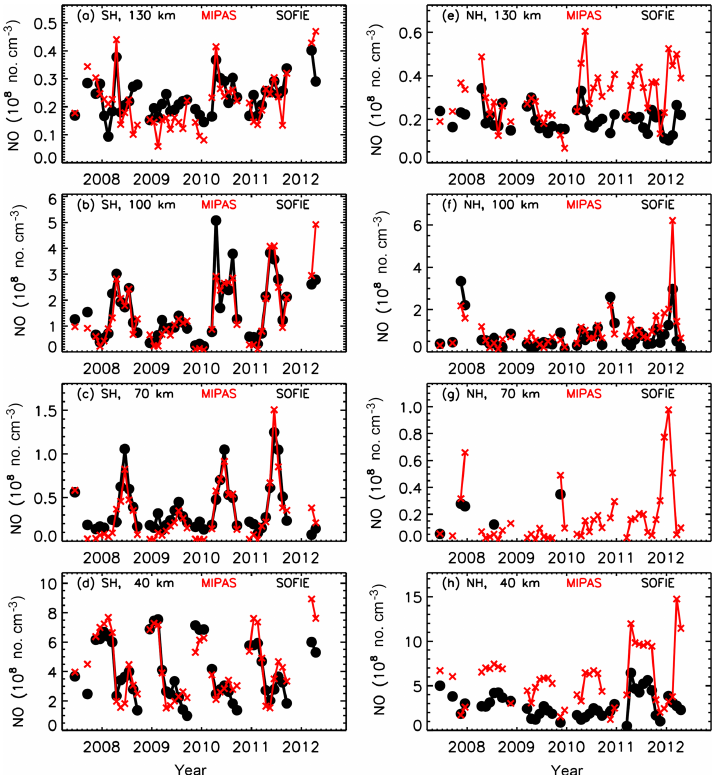
Figure 11. Comparison of SOFIE and MIPAS NO time series as monthly zonal means, for the coincidences shown in Fig. 6. SH results are shown for (a) 130km, (b) 100km, (c) 70km, and (d) 40km altitude. NH results are shown for (e) 130km, (f) 100km, (g) 70km, and (h) 40km